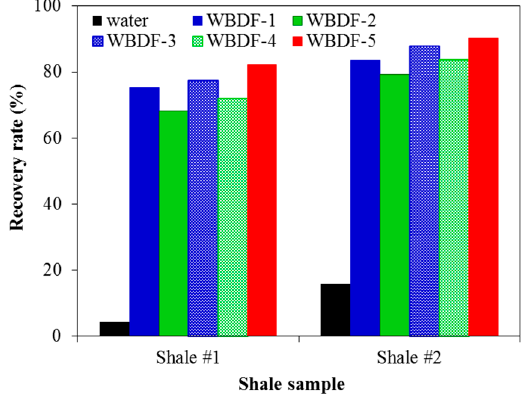
Figure 5. Shale recovery rates for different WBDFs.